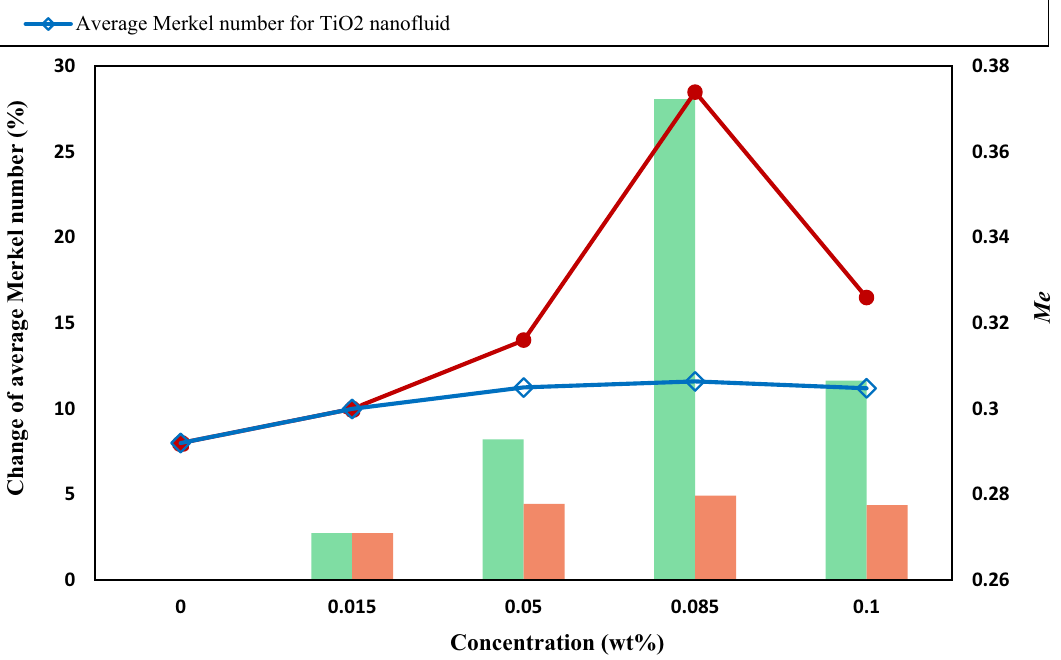
Figure 16. The average Merkel number of CFCT at diverse concentrations and five flow rates considering MWCNTs and TiO 2 nanofluids.